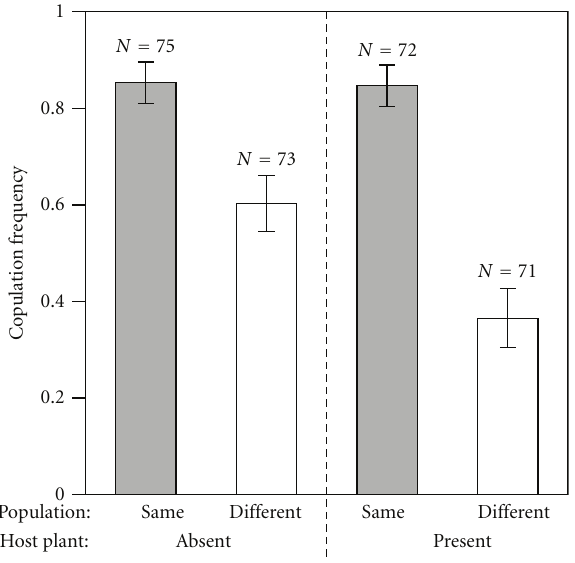
Figure 2: Mean ( ± SE) of copulation frequency among B. treatae individuals from their own host-associated population or the alternative host-plant-associated population when host plants were absent or present. Sexual isolation is indicated by a di ff erence between copulation frequency when paired with an individual from the “same” host plant population versus a “di ff erent” host plant population. The additional e ff ect of habitat isolation is indicated by a shift in the magnitude of the di ff erence between same and di ff erent host pairings when the host plant is present during the mating assay. Numbers above the SEs are the number of